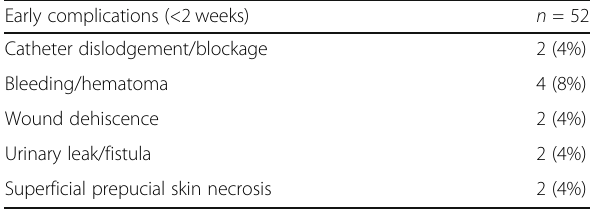
Table 6 Type of final procedure (urethroplasty) performed Type of final procedure performed